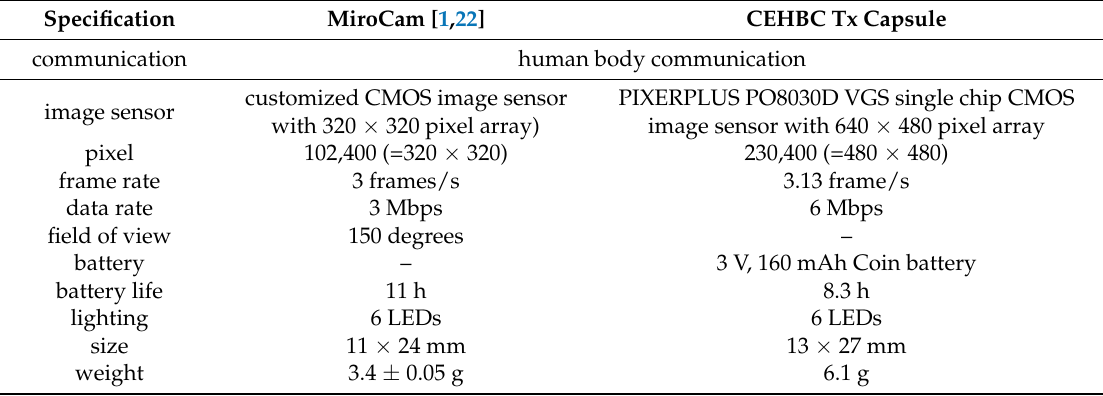
Table 6. Performance comparison of the capsule endoscope using human body communication